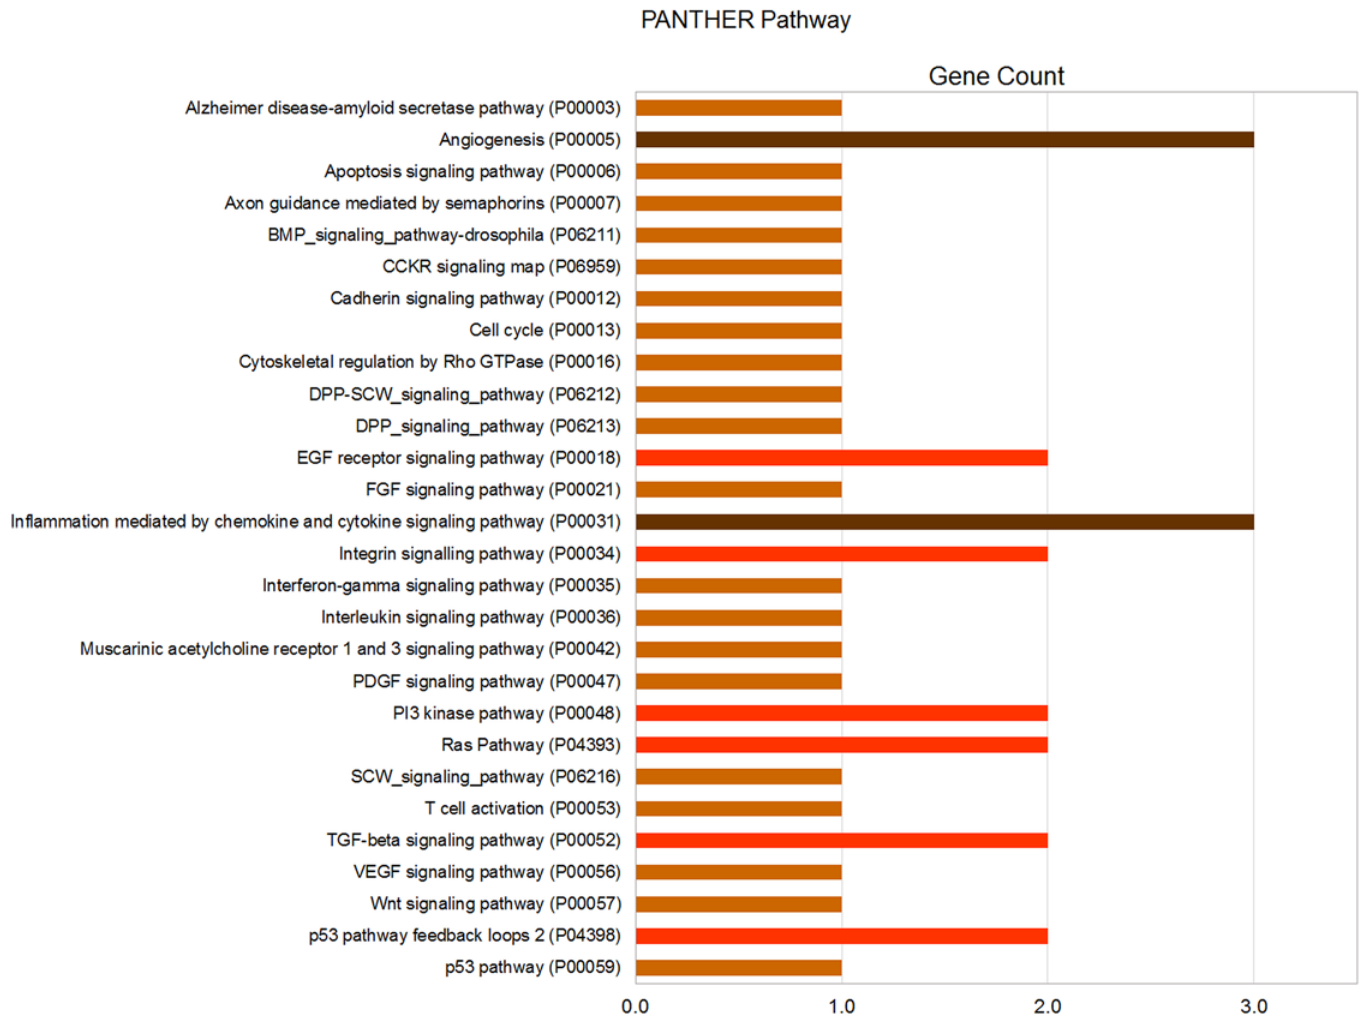
Fig 4. Pathway analysis for validated miRNA target genes. Pathways showing enrichment in validated targets genes for miR-377-5p and miR-663b.